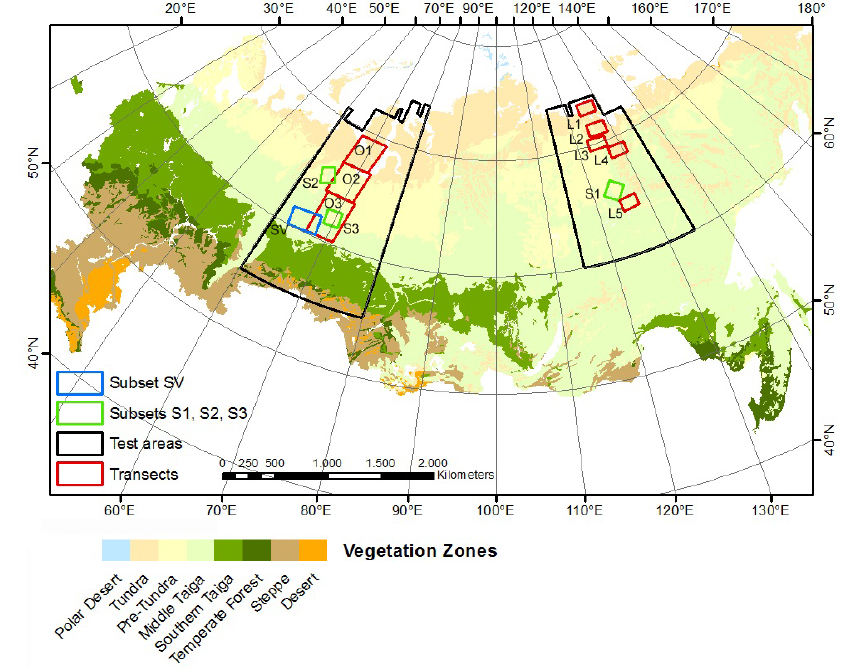
Figure 3. Major vegetation zones of the West Siberian Lowlands (Dataset IIASA [26]). The test areas of Ob basin and Delta and Lena basin and Delta are outlined in black. The extents of subsets and transects used for validation are shown in red, green and blue (compare Chapter 4: